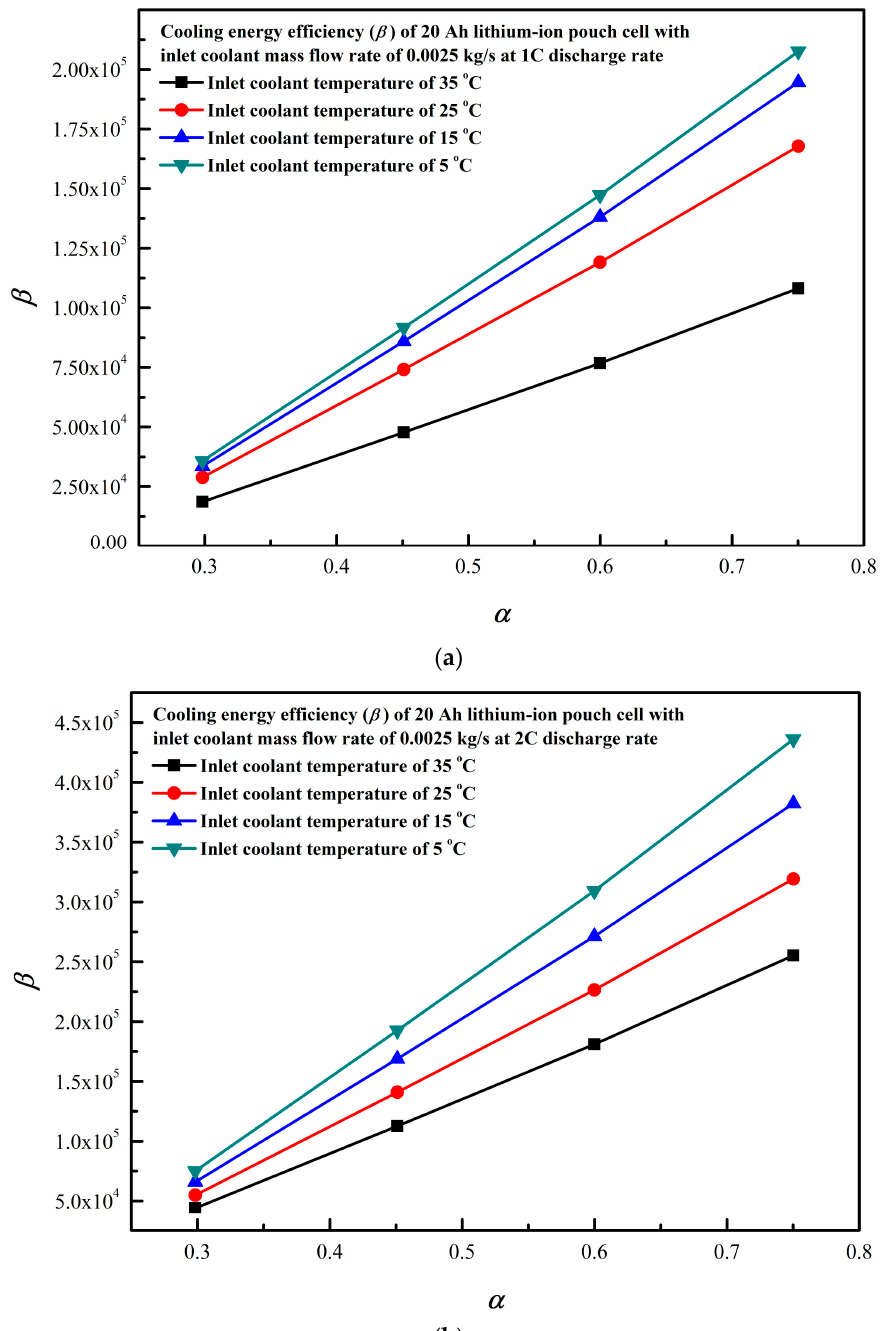
Figure 9. Cooling energy efficiency ( β ) of 20 Ah lithium-ion pouch cell with inlet coolant mass flow rate of 0.025 kg/s: ( a ) 1C; ( b ) 2C.